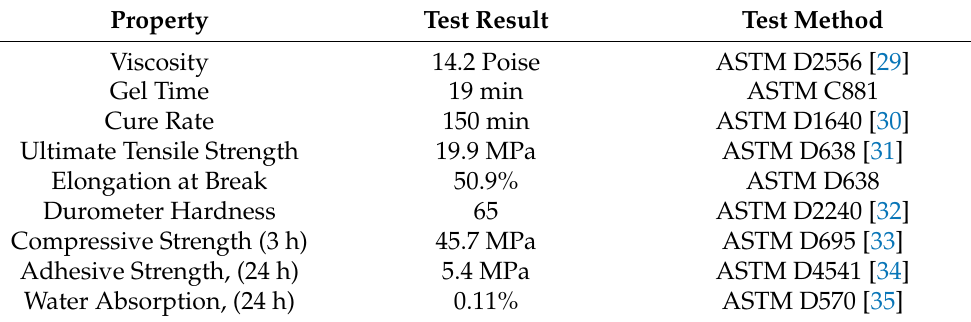
Table 1. Main properties of the epoxy resin binder.